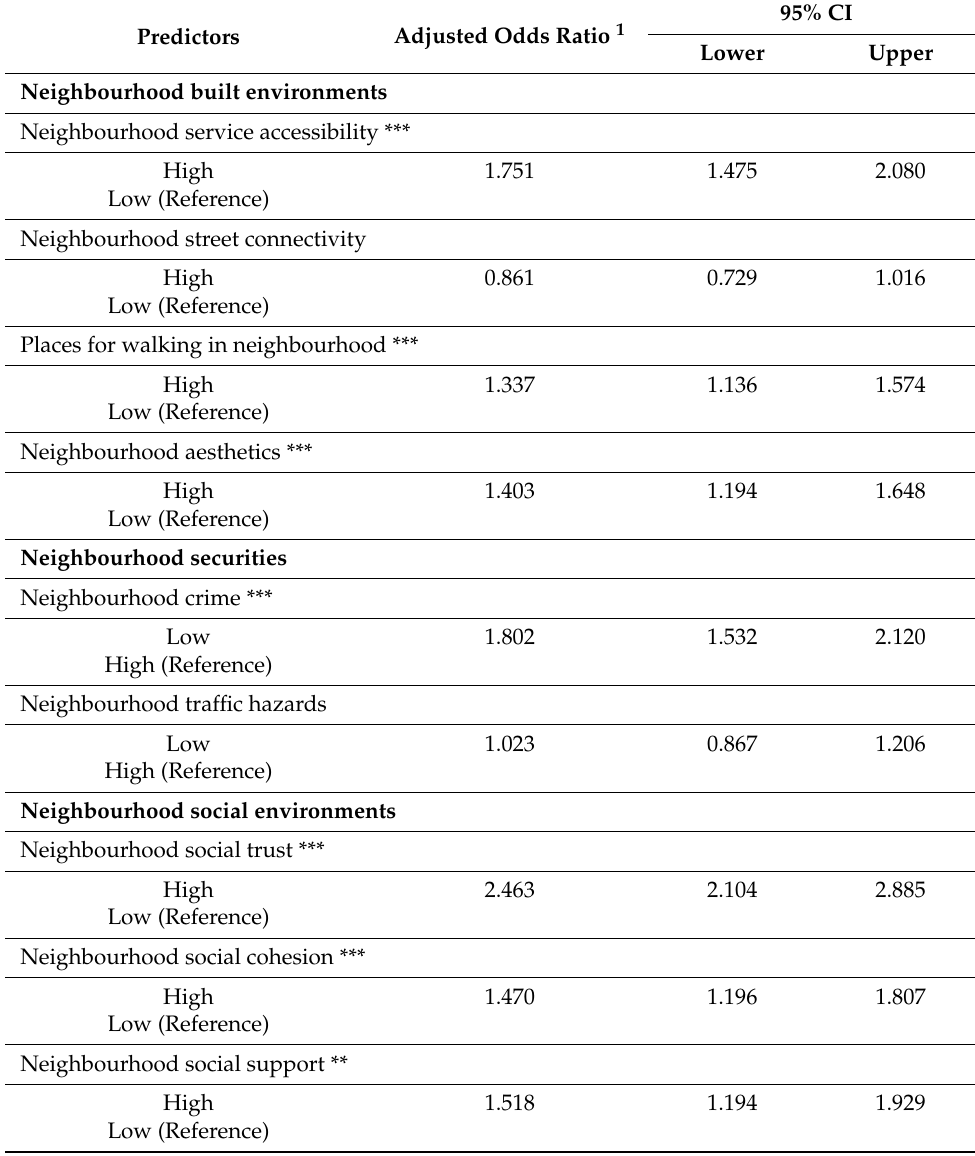
Table 5. Different dimensions of age-friendly environments as predictors of quality of life among Thai older